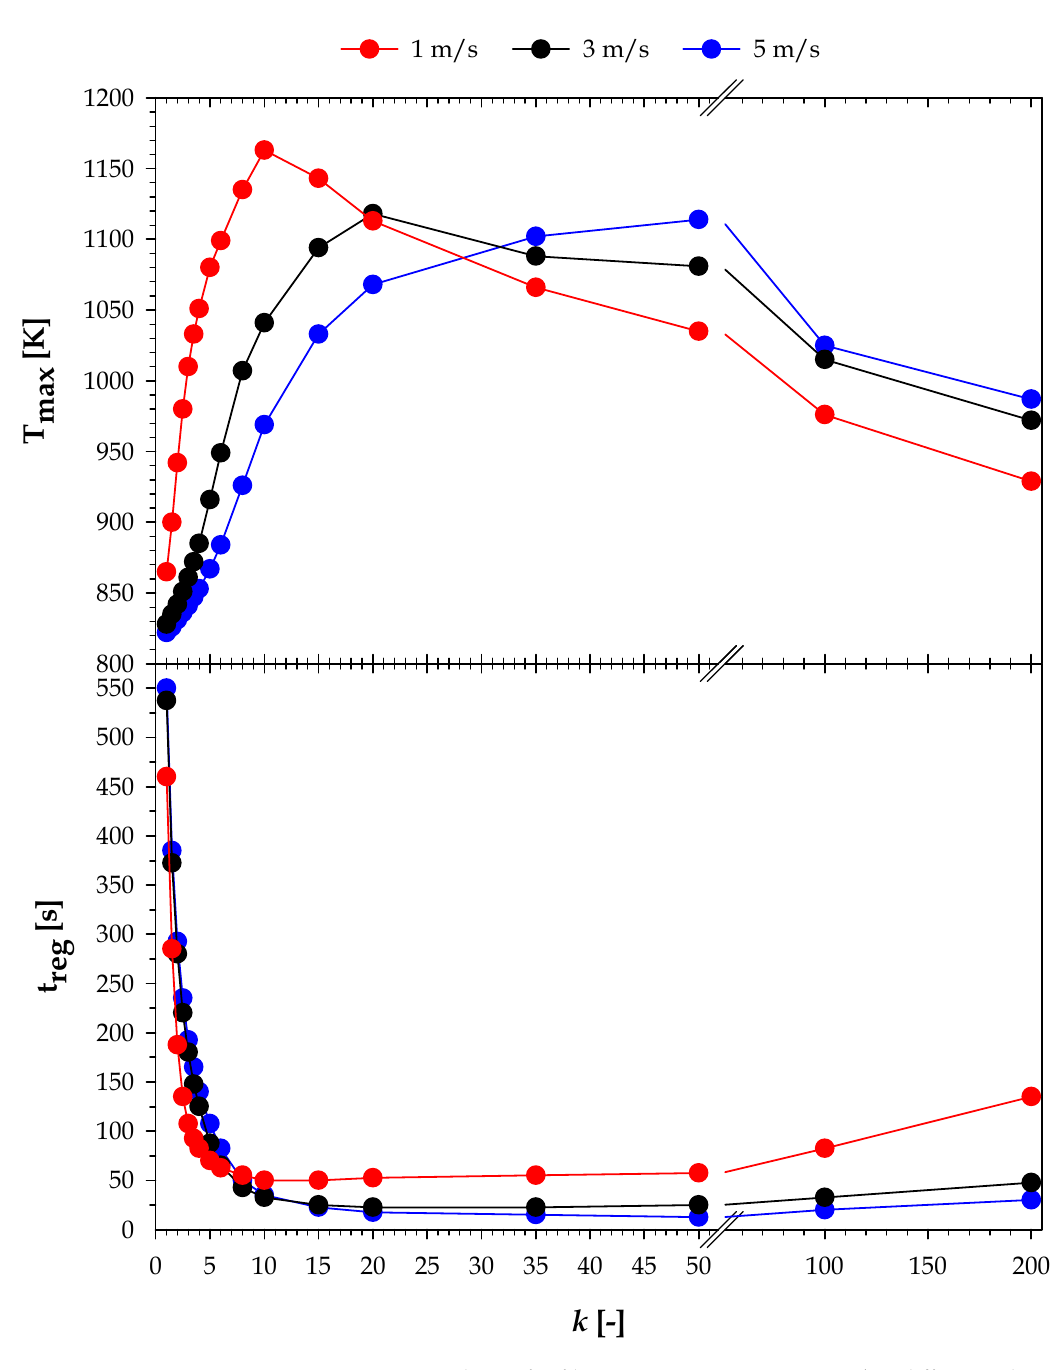
Figure 9. Maximum temperature, T max , and time for filter regeneration, t reg , versus k at di ff erent inlet gas